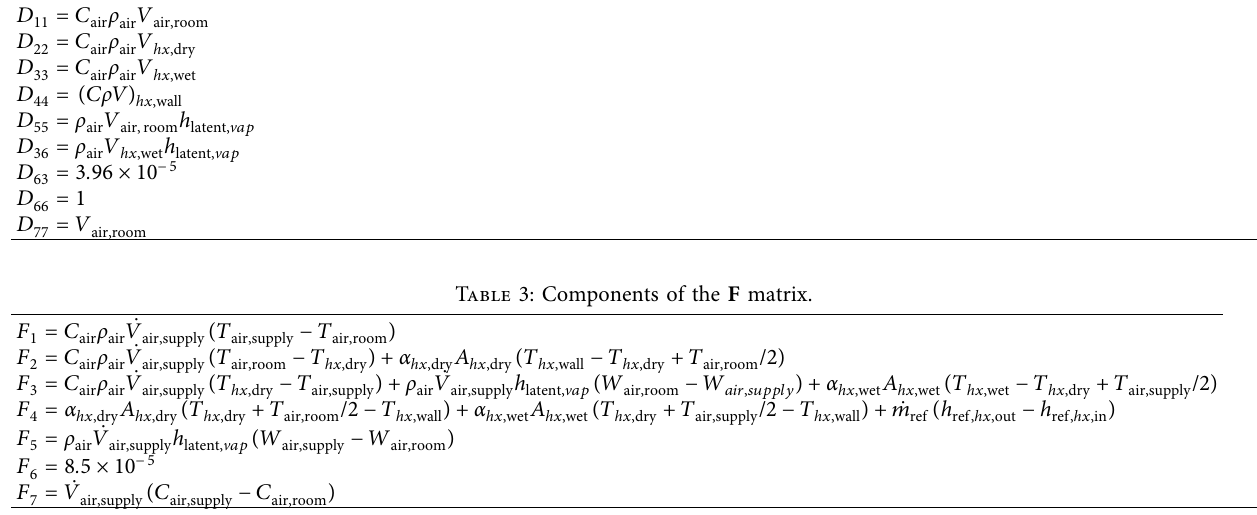
Table 2: Components of the D